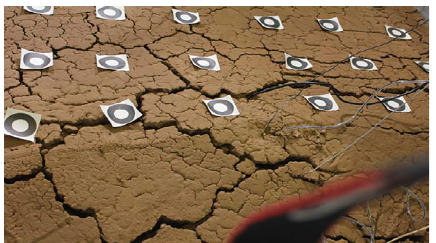
Figure 20: Loess slope surface at the 800gal.